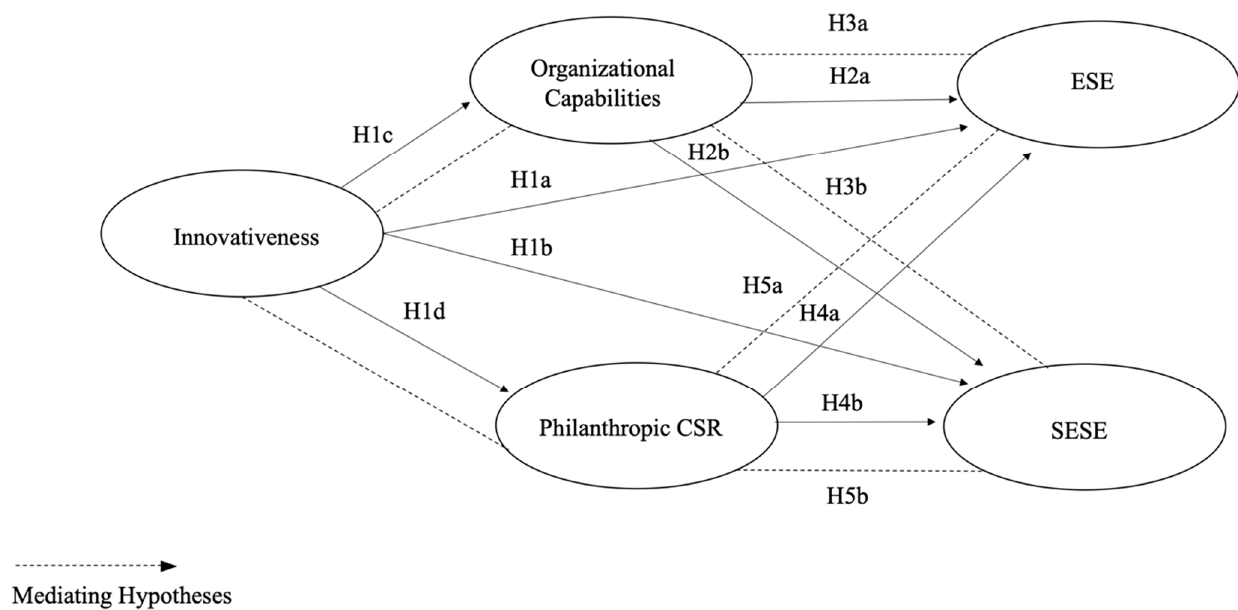
Figure 1. Conceptual model. Note: Connected lines indicate relationships among constructs; Dashed lines indicate indirect relationships among constructs.